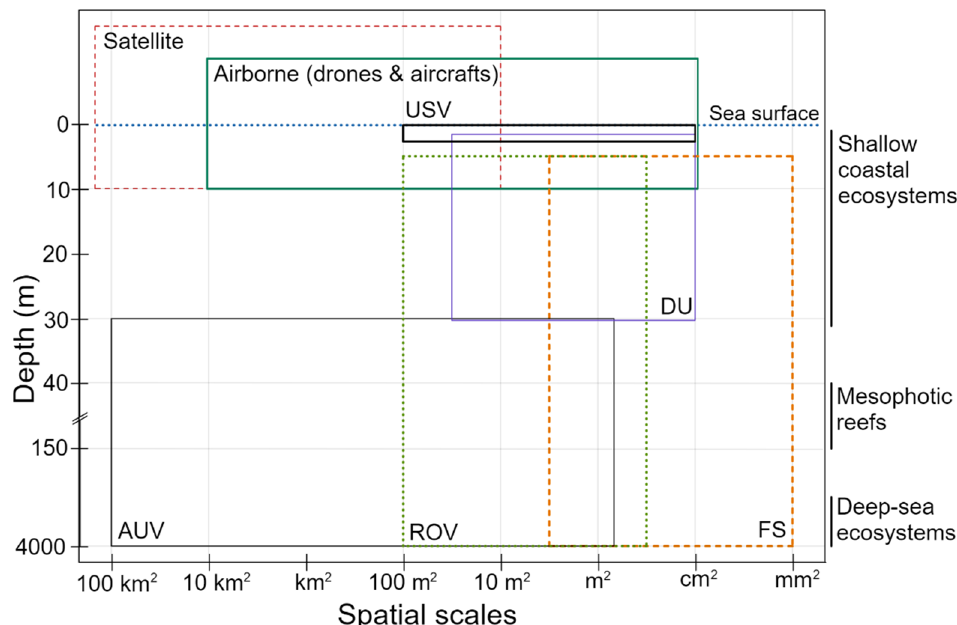
Figure 1. Present spatial scales of observation for hyperspectral imaging platforms in a marine context. This highlights the spatial extent to which each system can optimize its observations, plotted against the depth range of the system. Acronyms are defined by: unmanned surface vehicle (USV), diver units or systems (DU), autonomous underwater vehicle (AUV), remotely operated vehicle (ROV), and fixed stations (FS). Airborne includes drones and manned